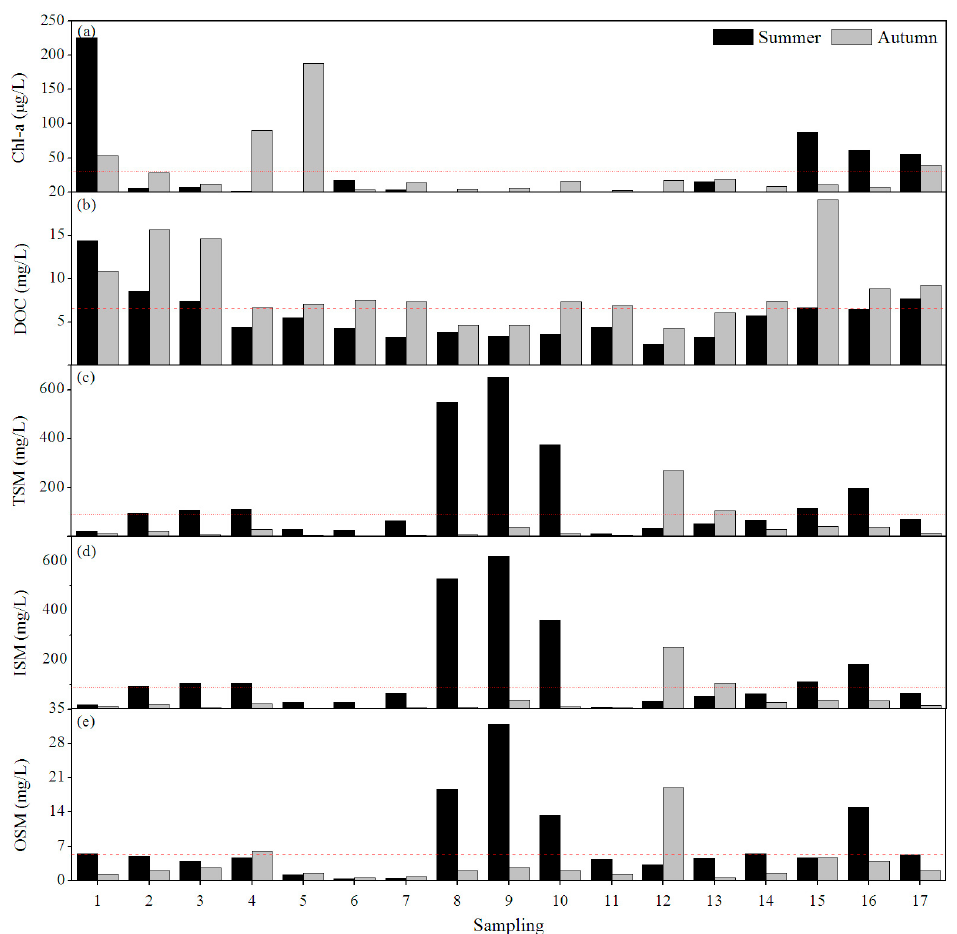
Figure 4. The histogram of DOC, Chl ‐ a, TSM, ISM and OSM concentrations in different sampling locations: ( a ) Chl ‐ a; ( b ) DOC; ( c ) TSM; ( d ) ISM; and ( e ) OSM. The red dash dot lines represent the average values in all the sampling locations.